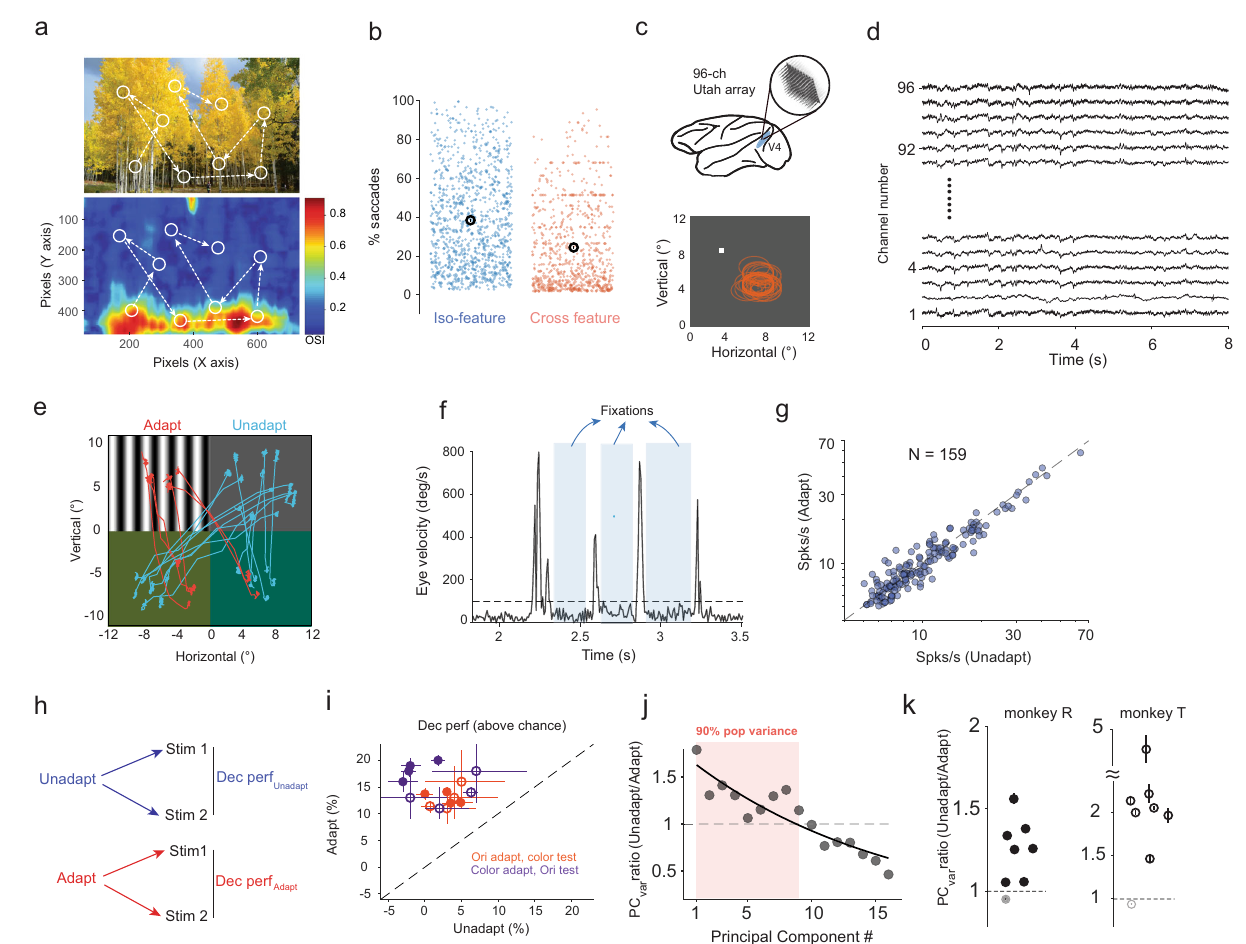
Fig. 1 | Rapid adaptation during free-viewing improves coding accuracy in neural populations. a Sequence of simulated saccades (arrows) with pseudo receptive fi eld (RF) positions (circles) overlaid on natural image 49 (Olmos, A., Kingdom, F. A. A. (2004). A biologically inspired algorithm for the recovery of shading and re fl ectance images, Perception, 33, 1463 - 1473. http://tabby.vision. mcgill.ca/). Bottom: Heatmap of orientation selectivity index for the same image. b Percentageofsimulatedsaccadesconnectingiso-feature(blue)andcross-feature (orangedots)patchesforeachnaturalimage.Blackcirclesandbarsrepresentmean and s.e.m. c Top: Schematic of a chronically implanted 96 channel Utah array in macaque V4. Bottom: RF locations (orange circles) of single units with respect to fi xationpoint(whitedot). d Snippetofvoltagewaveformsrecordedsimultaneously from all 96 channels. e Stimulus con fi guration for free-viewing experiments. Red and blue traces show saccades connecting RF centers during ‘ adapt ’ and ‘ unadapt ’ conditions. f Exampleof fi xationdetection(shadedregions)fromeyevelocitytrace during free-viewing. g Firing rates for individual neurons ( N =159) during una- dapted and adapted conditions ( FR mean adapt = 11.8 Hz, FR mean unadapt = 12.1 Hz; two-sided